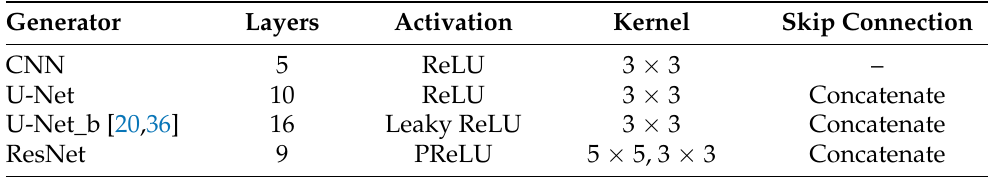
Table 1. Network models considered as generators for a Conditional Generative Adversarial Network